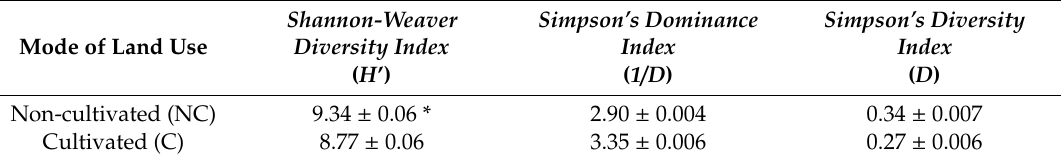
Table 5. General diversity of studied soil samples based on DGGE banding